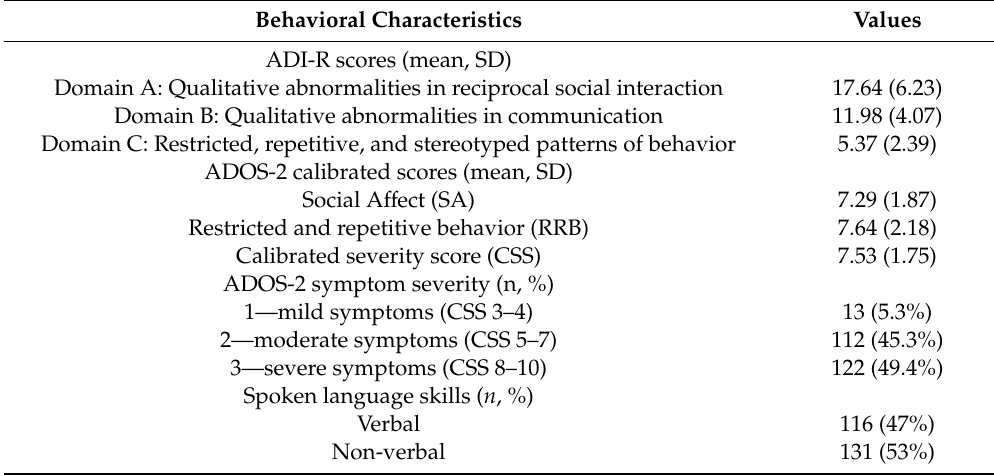
Table 2. Behavioral characteristics of the participants with autism spectrum disorders